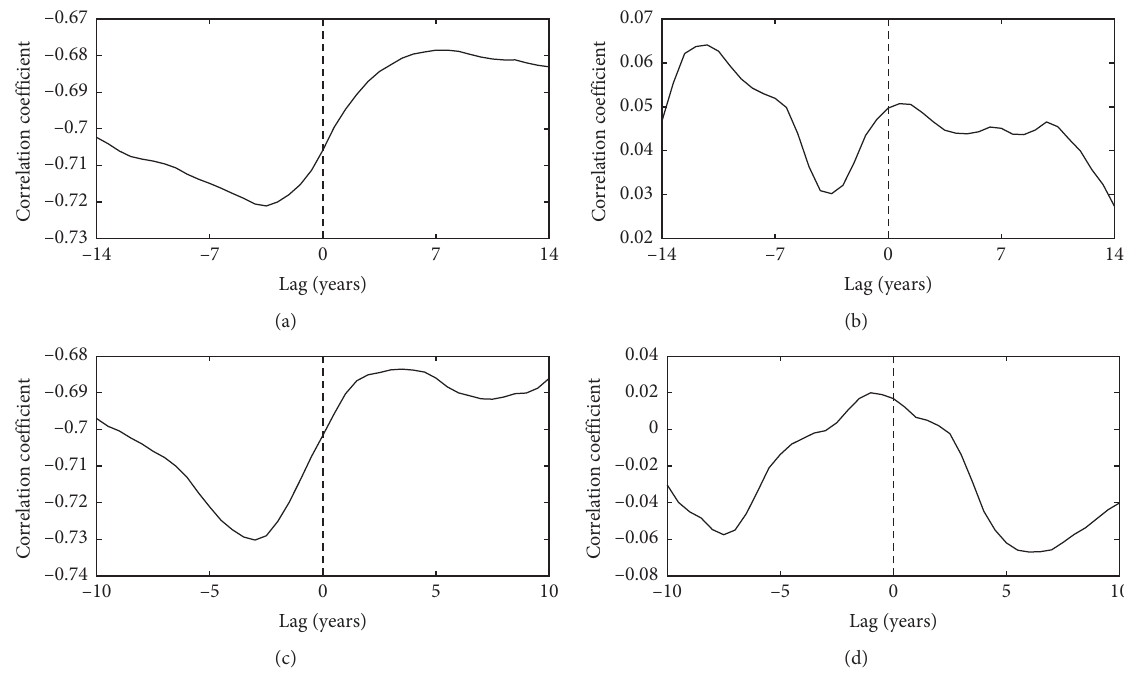
Figure 2: Cross-correlation coefficients of daily SSN-CRI and SSN-SWS for the two solar cycles 23 and 24, separately. The abscissa designates the time delay with respect to the daily sunspot numbers. (a) SSN-CRI solar cycle 23. (b) SSN-SWS solar cycle 23. (c) SSN-CRI solar cycle 24. (d) SSN-SWS solar cycle